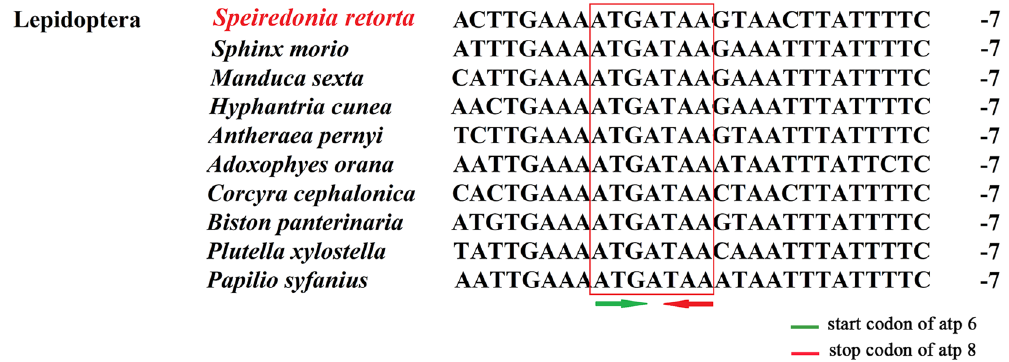
Figure 6. Alignment of atp8 and atp6 overlap among Lepidopteran species and other insects, with the number of intergenic nucleotides shown on the right.